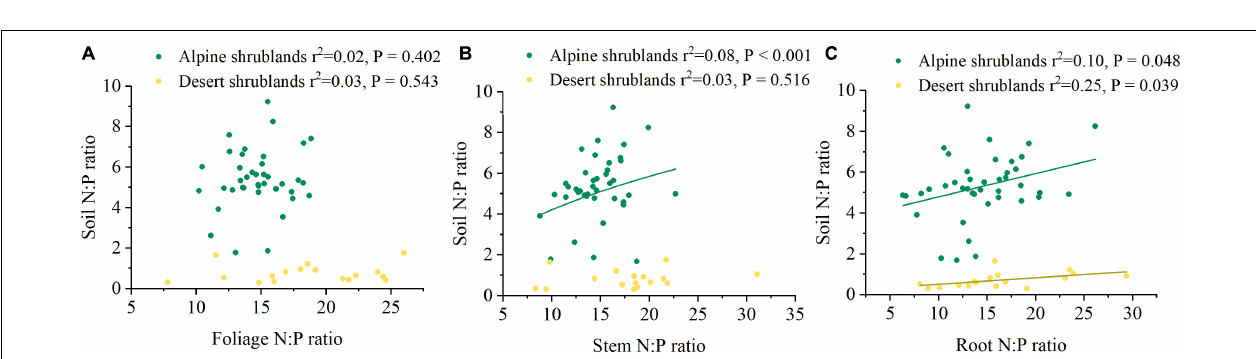
FIGURE 5 | The relationships among mean annual precipitation (MAP) (A) , mean annual temperature (MAT) (B) , and soil nitrogen: phosphorus (N:P) ratio. Yellow circles indicate desert shrublands, while green circles indicate alpine shrublands.